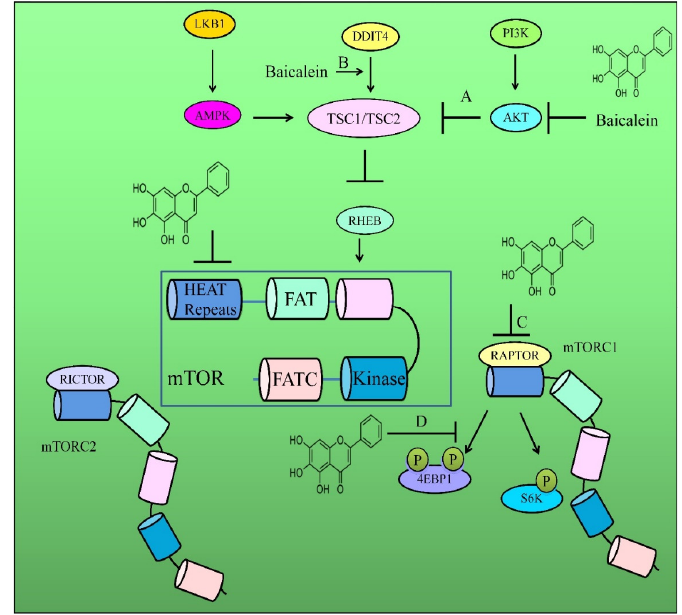
Figure 2. Diagrammatic representation of AKT/mTOR pathway. (A) AKT phosphorylates TSC2 and GTP-loaded RHEB activates mTORC1 (mammalian TOR complex 1). However, TSC1/TSC2- mediated hydrolysis of GTP to GDP switched RHEB from a functionally active GTP-bound state to an inactive GDP-bound state and inhibited the functions of mTOR. (B) DDIT4 has been documented to block the activity of mTORC1 by activation of TSC1/2 complexes. (C,D) Baicalein inhibited mTORC1 (RAPTOR) and mTORC1-mediated phosphorylation of 4EBP1 and